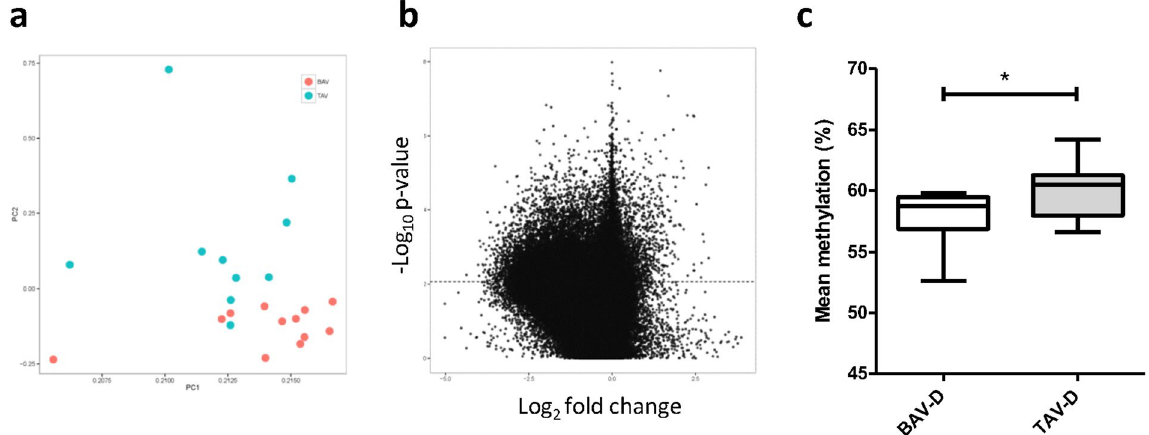
Figure 4. Differential DNA methylation, BAV and TAV dilated (D) ascending aortas. ( a ) Principle component analysis of BAV (pink) and TAV (blue) DNA methylation using M-values; ( b ) Volcano plot of − log10 (P-value) against log2 (fold-change) of beta values, representing differential methylation between BAV and TAV (t-test). Dashed line represents the Bonferroni-adjusted threshold for statistical significance; ( c ) mean DNA methylation, presented as (%) ± standard deviation (t-test). * P ≤ 0.05. N = 14 BAV and N = 13